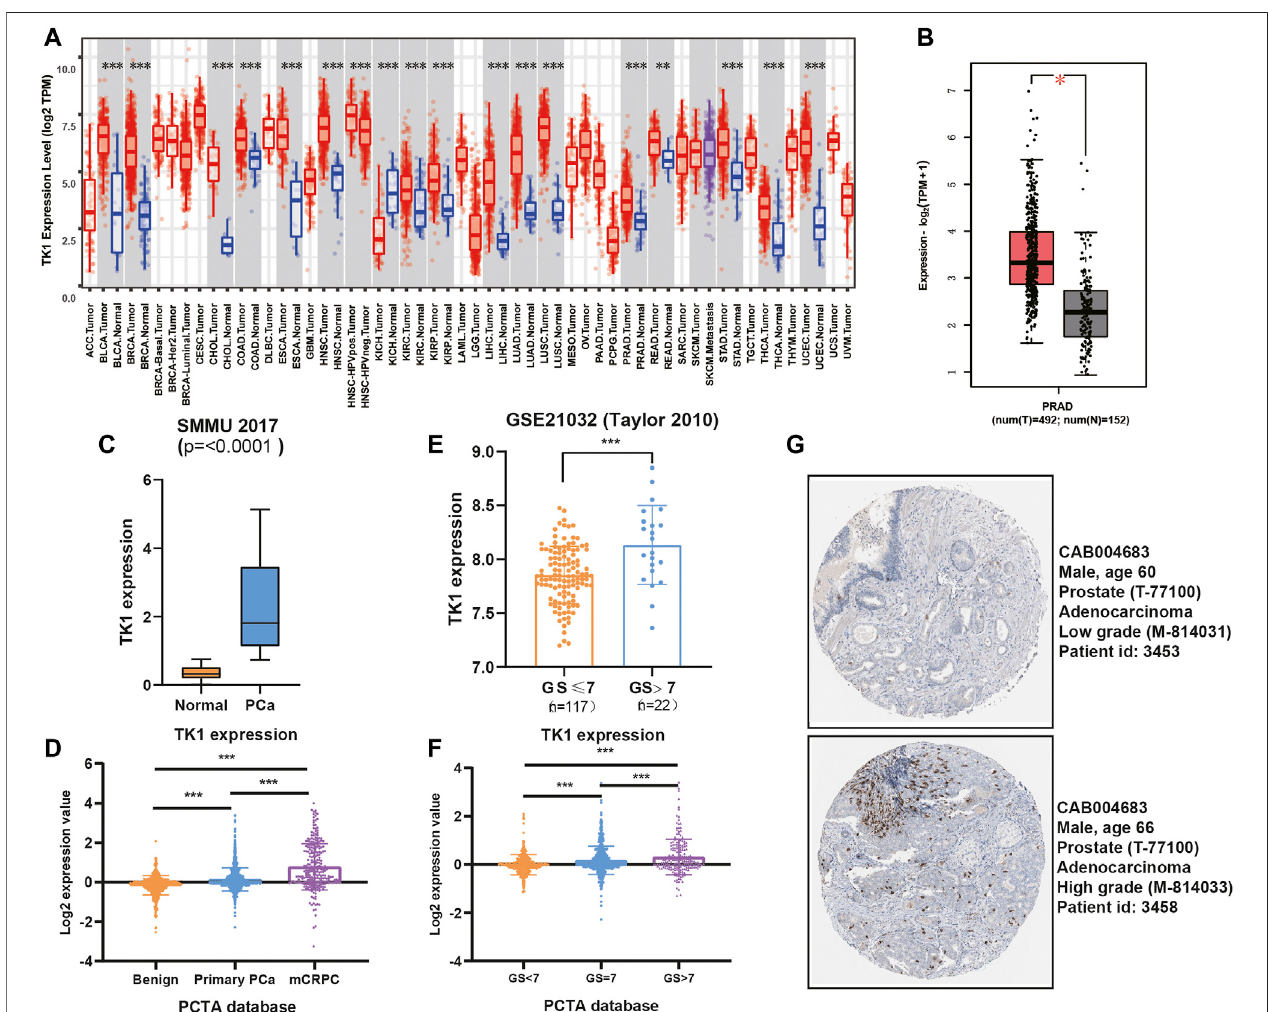
FIGURE1| TK1expressioninPCapatients. (A) TK1expressioninvariouscancertissuesandnormaltissues. (B) TK1expressioninTCGAPRADcohort. (C,E) TK1 expression across several independent clinical studies. (D,F) TK1 mRNA expression in the PCTA dataset. (G) TK1protein expression showed byimmunohistochemical staining in high-grade and low-grade patient. The pictures were taken from the Human Protein Atlas dataset. * p < 0.05, ** p < 0.01, *** p < 0.001; GS, Gleason score; mCRPC, metastatic castration resistant prostate cancer.